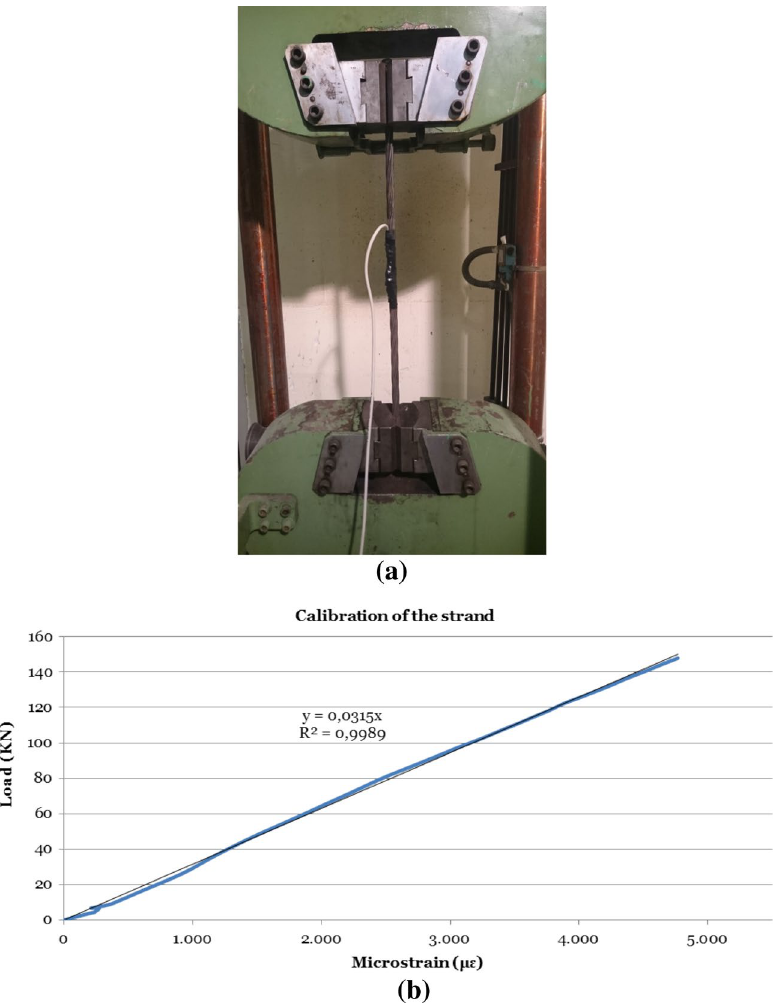
Figure 7. Calibration of the cable instrumentation method by the installation of unidirectional strain gauges: ( a ) prestressing strand in load-bearing gantry; ( b ) load/deflection curve during calibration